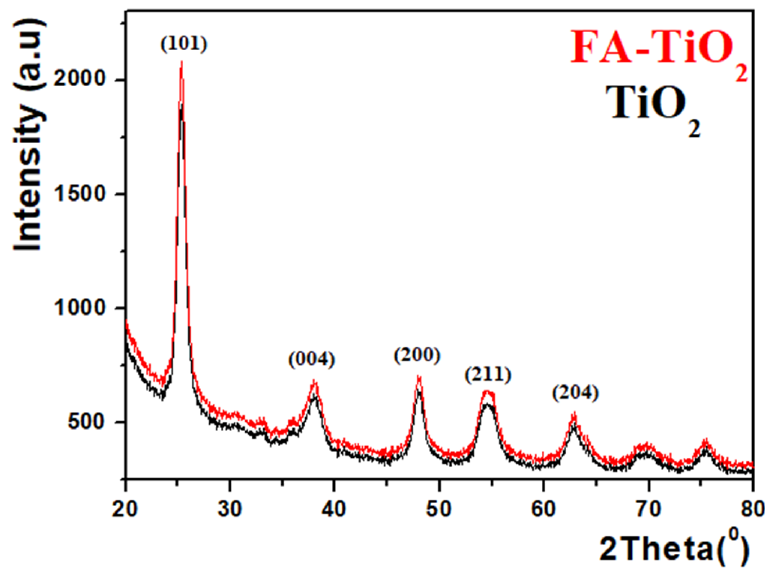
Figure 1. XRD patterns of TiO 2 NPs and FA-TiO 2 nanocomposite prepared using the solvothermal process.